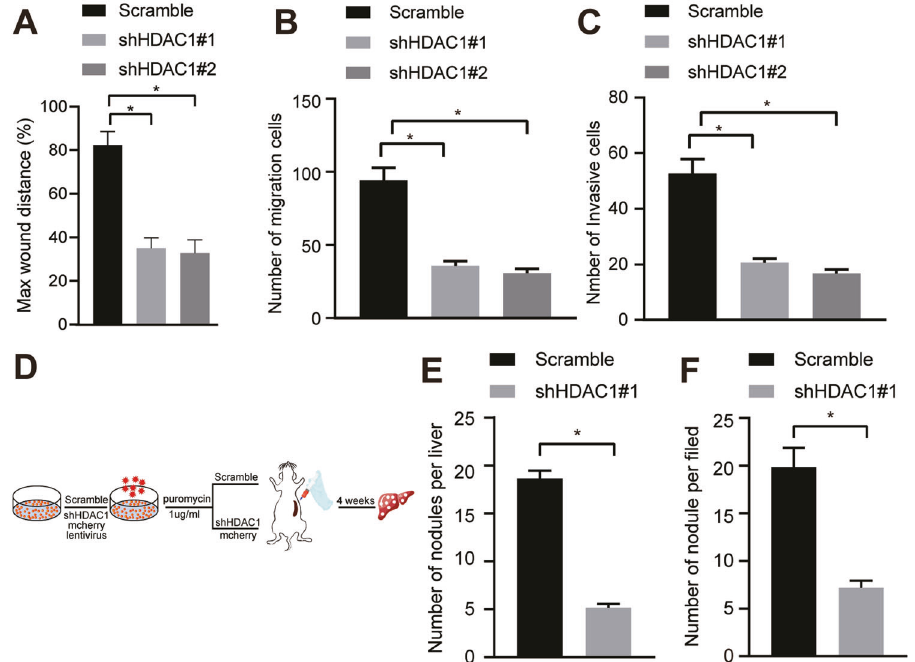
Fig. 3 Loss of HDAC1 represses CC cell migration and invasion in vivo and in vitro. A Wound healing ability of TFK-1 cells upon HDAC1 silencing evaluated by scratch test. B TFK-1 cell migration upon HDAC1 silencing assessed by Transwell assay. C TFK-1 cell invasion upon HDAC1 silencing tested by Transwell assay. D Program fl owchart of tumor metastasis model developed in nude mice and HDAC1 silencing. E The number of nodules visualized on the liver surface in tumor-bearing nude mice in response to HDAC1 silencing. F Analysis for HE staining of nodules in the liver of tumor-bearing nude mice in response to HDAC1 silencing. * p < 0.05. In panels ( A – D ), data were compared by one-way ANOVA with Tukey ’ s post hoc test. In panels ( E ) and ( F ), data were compared by unpaired t -test. The cell experiment was independently repeated three times. n = 6 for animal